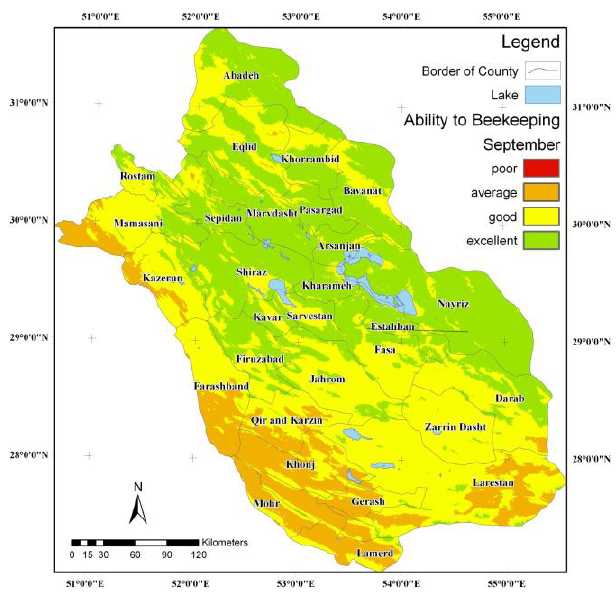
Fig. 6. Suitability of climate conditions for beekeeping in